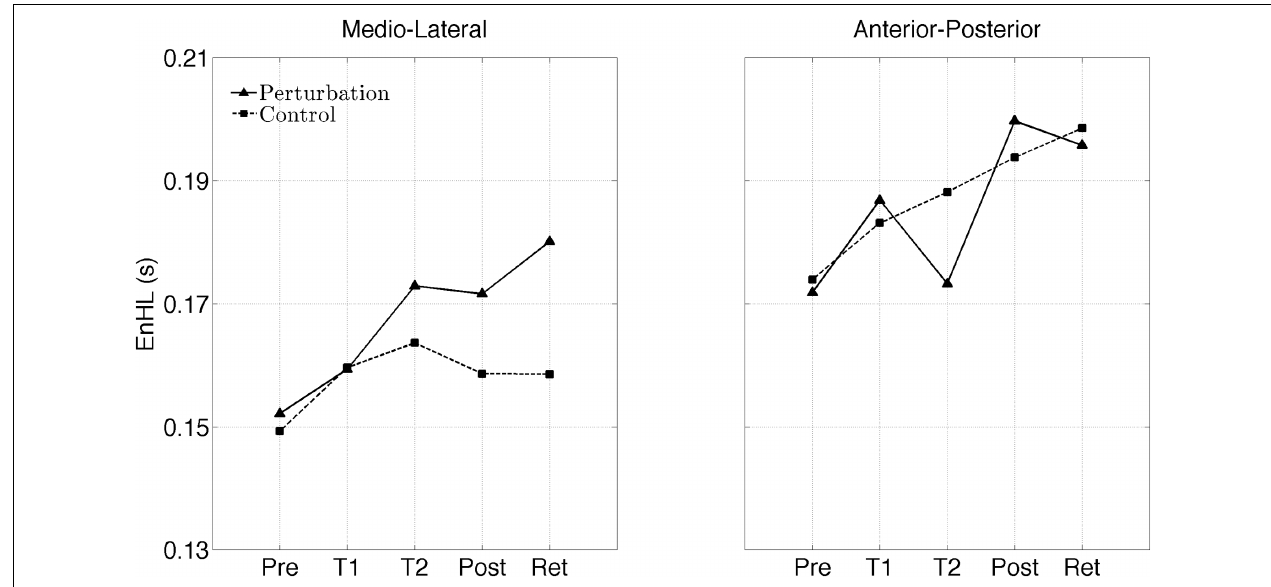
FIGURE 3 | Changes of the EnHL during and after treadmill intervention for the ML (left) and AP (right) directions of the original CoP data.